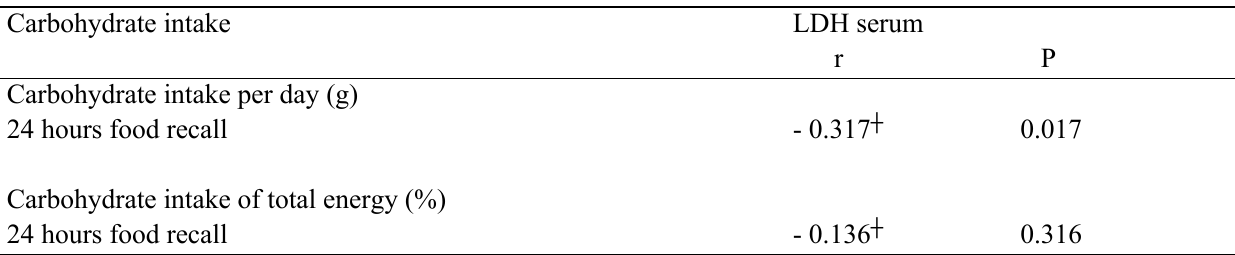
Table 4. The correlation between carbohydrate intake with LDH serum activity (n=56) Carbohydrate